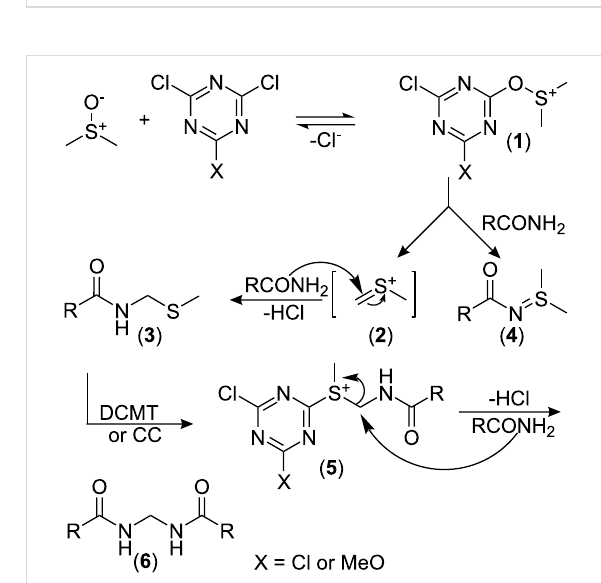
Scheme 5: Plausible reaction mechanism of amide with CC- or DCMT-activated